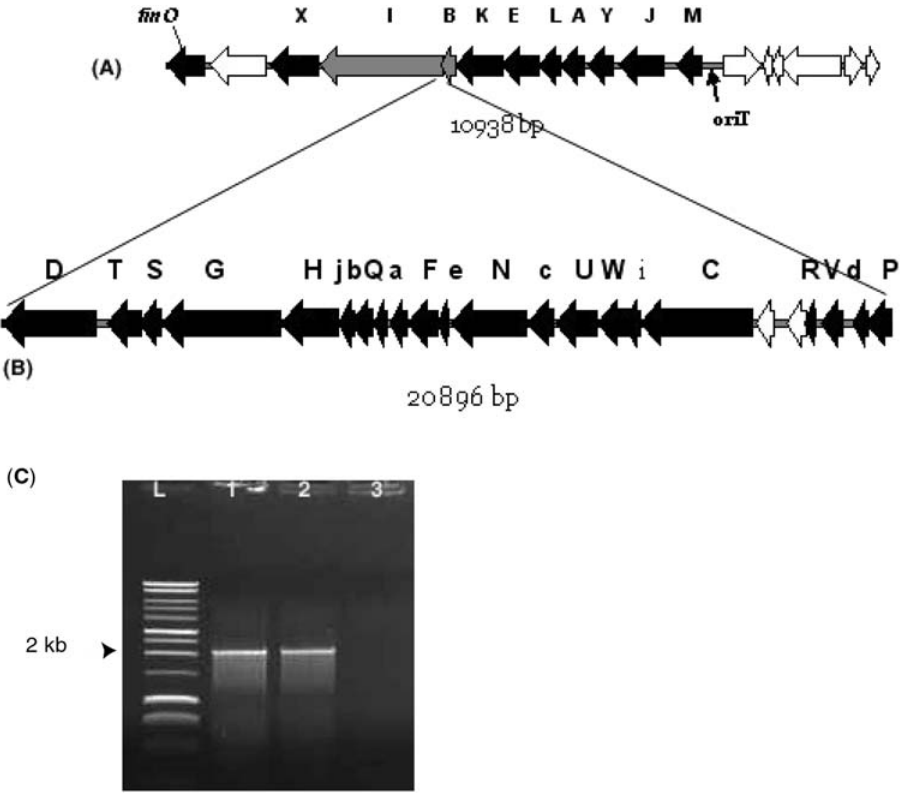
Figure 3. Genetic map of the transfer region of pAPEC-1 (A), ORFs of pAPEC-O2-ColV absent in pAPEC-1 (B). Capital letters represent tra genes and lower case letters represent trb genes. Black arrows represent known ORFs genes, grey arrows represent truncated genes, and white arrows represent hypothetical protein genes. PCR of the traI-traB region on 0.8% agarose gel (C) , (L) 10 kb ladder (Promega), (1) x 7122, (2) x 7346, (3) x 6092.